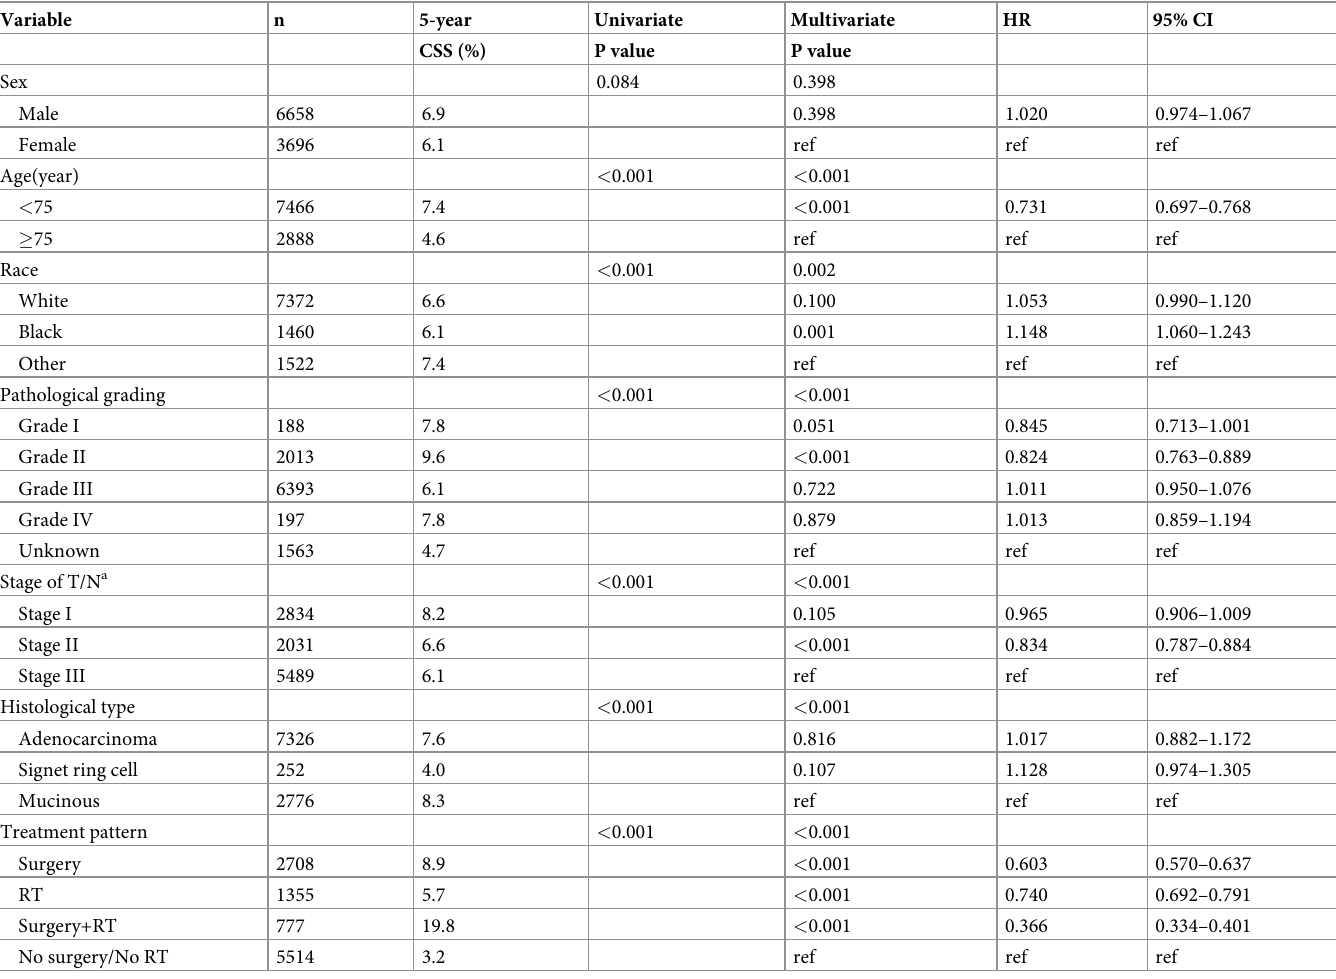
Table 2. Univariate and multivariate survival analyses of patients with advanced gastric cancer according to various clinicopathological